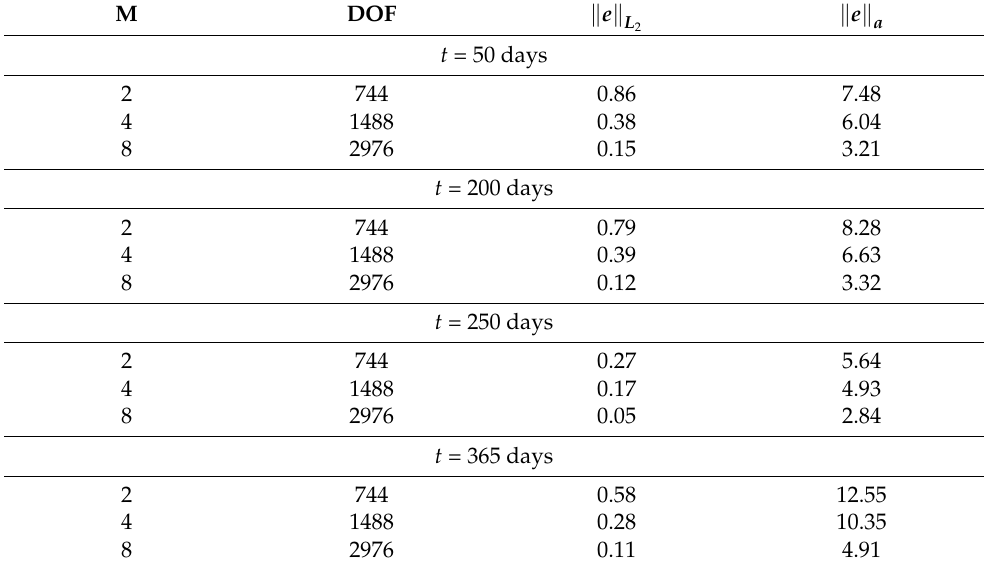
Table 3. Relative L 2 and energy errors (%) for different number of multiscale basis functions (DOFf = 172,681). Case 1: structured basalt fibers.